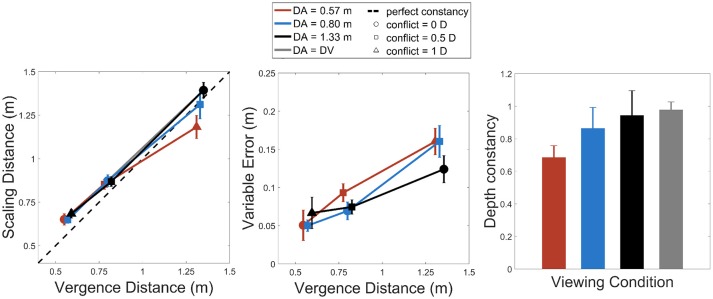
Left: scaling distances as a function of vergence distance for the three accommodation distances (red: 57 cm, blue: 80 cm, and black: 133 cm). Middle: variable error as a function of vergence distance for the same conditions. Right: slopes of depth constancy as a function of accommodation distances. The gray bar represents the condition where accommodation distance equals vergence distance. Vertical error bars show 95% Cousineau-Morey confidence intervals for within-subjects designs (Cousineau, 2005; Morey, 2008).